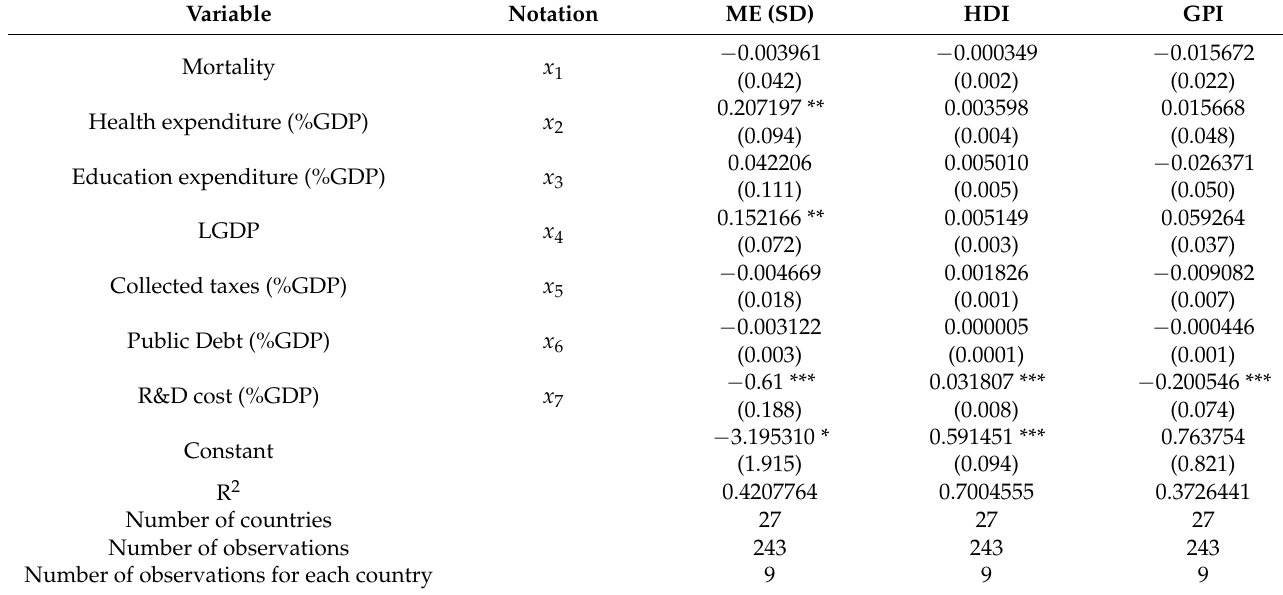
Table 3. Determinants of MEs, the HDI, and the GPI for NATO countries (fixed effects panel data model, 2008–2016). Variable